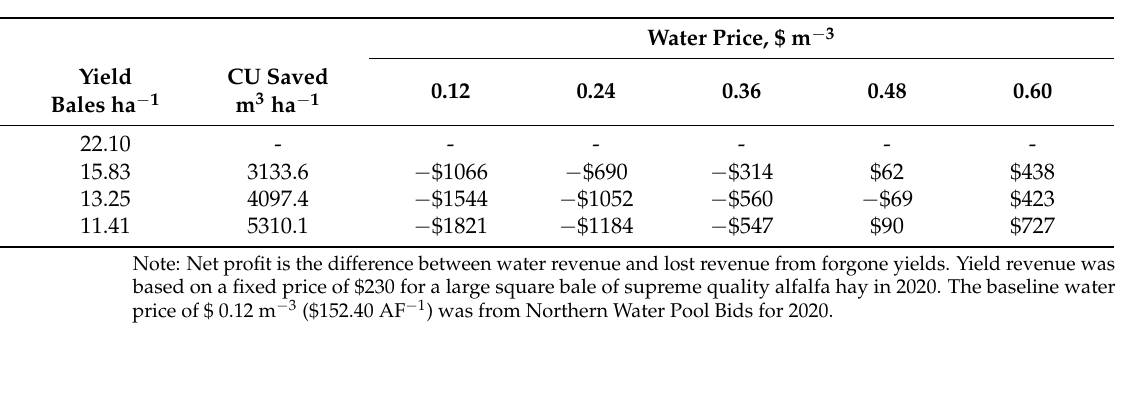
Table 7. Net profit ($ ha − 1 ) from leasing saved CU at different water